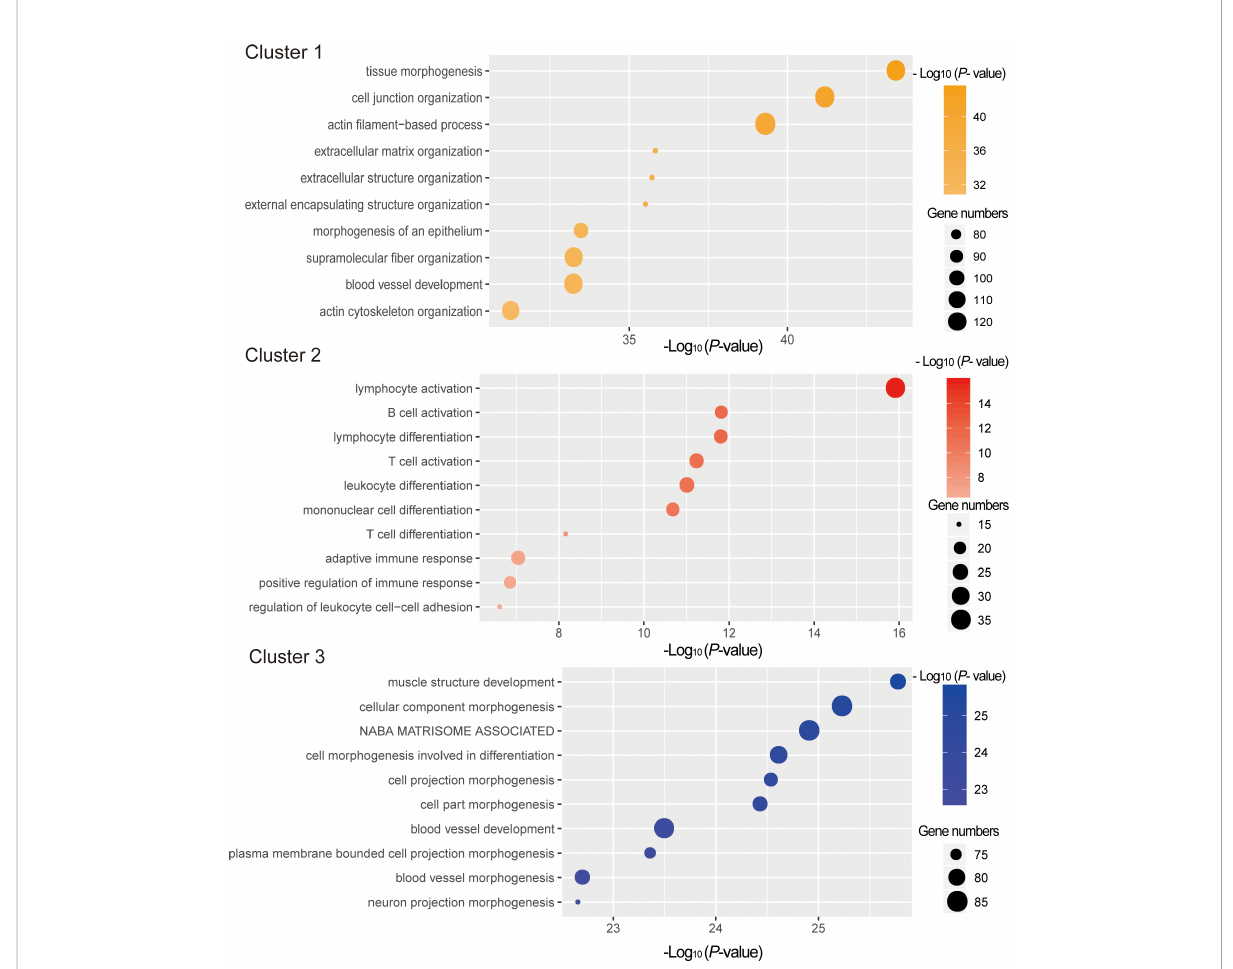
FIGURE 5 Function enrichment analysis of DE mRNAs in different clusters. The x-axis indicates – log (P - value). The y-axis indicates functional